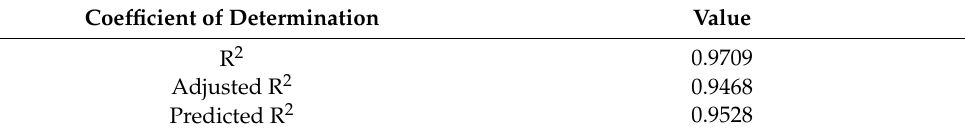
Table 14. Coefficient of determination for smoke.